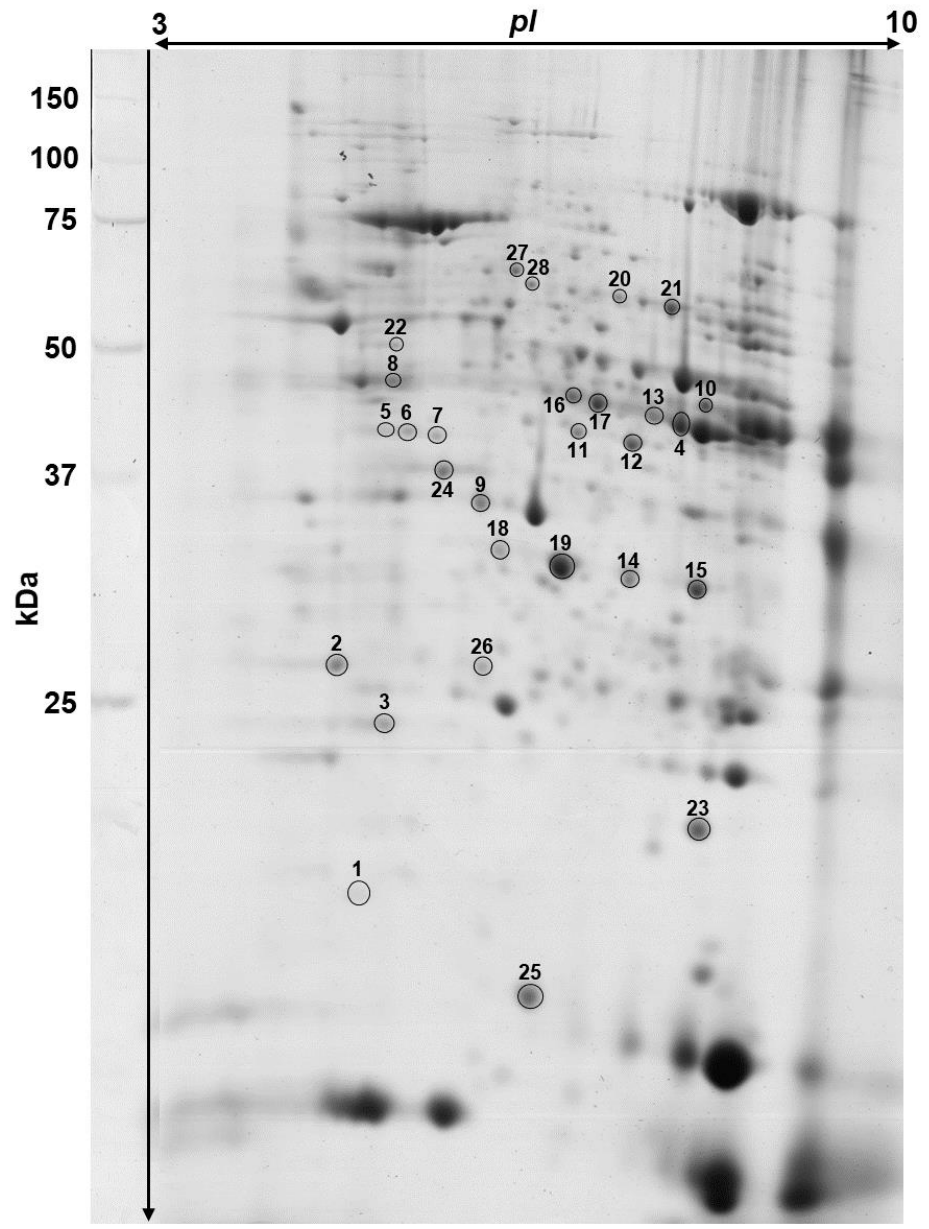
Figure 2. Representative two-dimensional electrophoresis gel image of the mouse heart proteome. Differentially expressed proteins between the animals fed standard diet (STD) and experimental high fat diets are indicated by numbers. Protein spot numbers refer to those presented in the heat map (Figure 3) and Table 3.